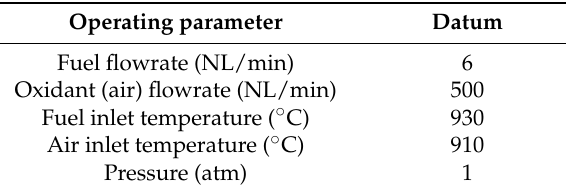
Table 2. Base case operating